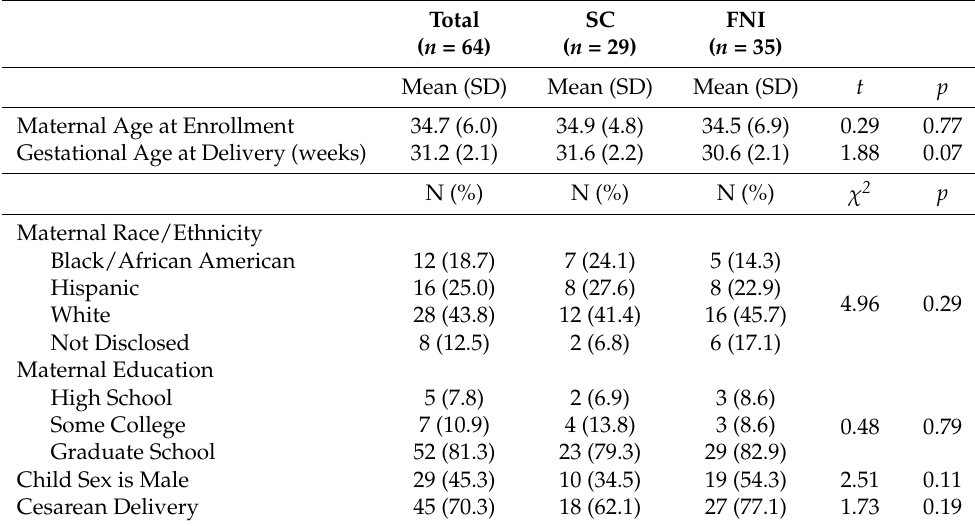
Table 1. Demographic and clinical